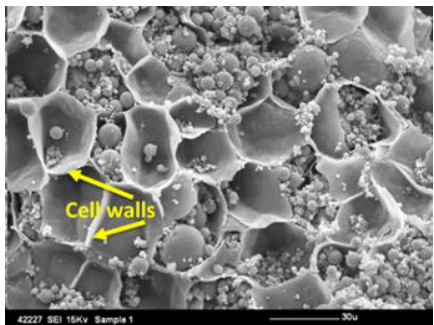
Figure 2. Surface of an almond seed post-mastication showing ruptured cell walls (dietary fibre). Micrograph, produced by scanning electron microscopy, of the surface of a masticated particle of almond seed. The cell walls (dietary fibre) have been ruptured (as marked by arrows) by chewing, exposing the nutrients inside the cells of the almond cotyledon tissue. Many of these cells still contain protein and lipid (oil bodies and coalesced oil droplets), which are potentially available for digestion (i.e., bioaccessible). Nutrients in intact cells below the fractured surface are not bioaccessible because the dietary fibre acts as a physical barrier to digestion. The scale bar is 30 μm.